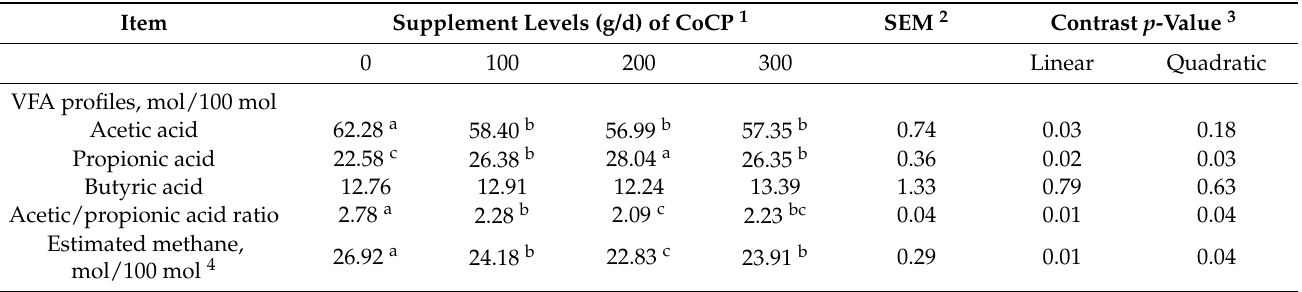
Table 4. Effects of dietary CoCP supplementation (g/d) on the ruminal volatile fatty acid (VFA) profiles and methane (CH 4 ) estimation in goats.